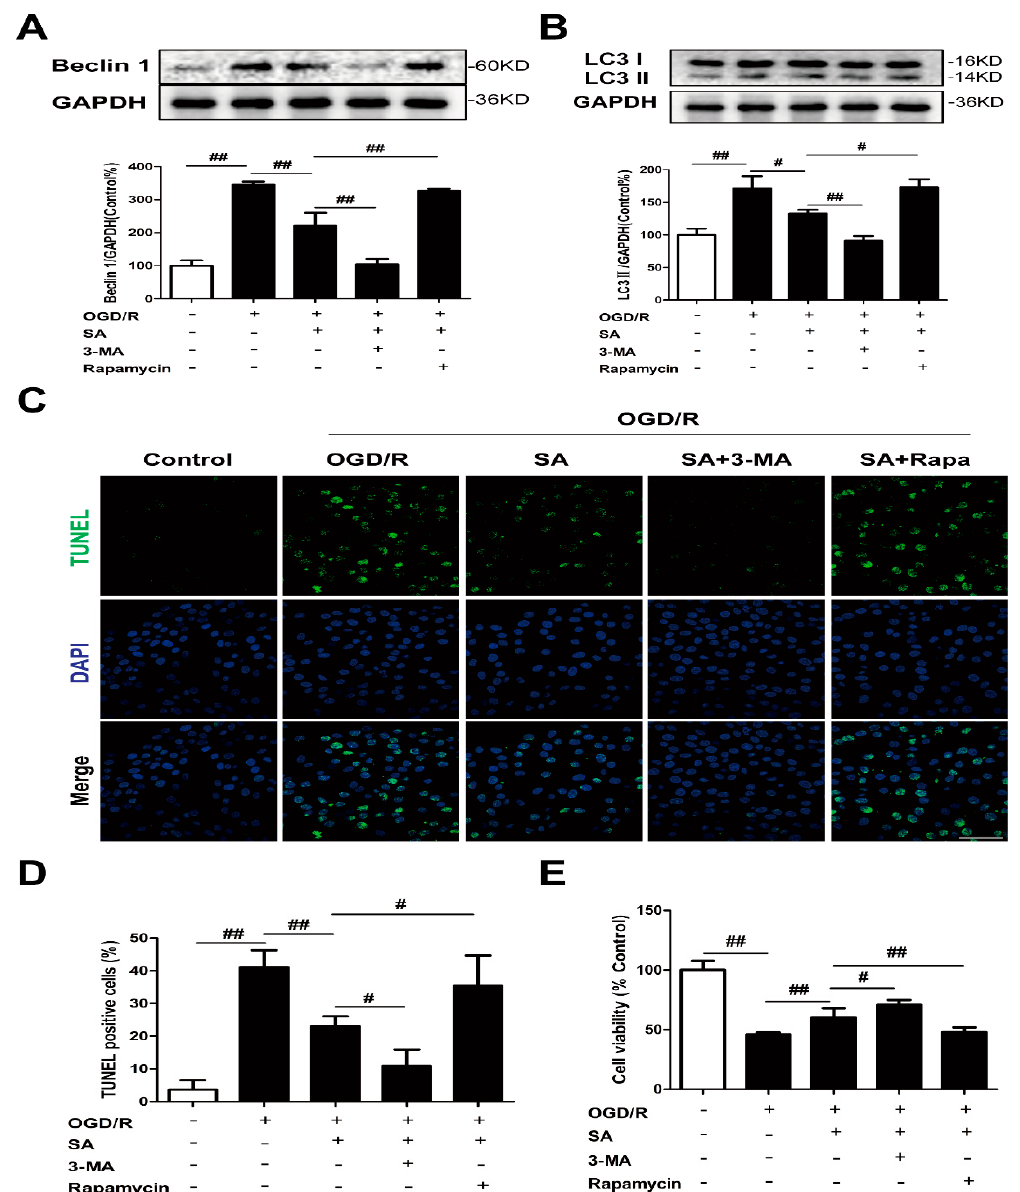
Figure 4. Autophagy contributes to the neuroprotective effects of SA in PC12 cells. PC12 cells were treated with SA (10 μ M) and 0.1 μ M rapamycin or 3 mM 3-MA and then exposed to OGD/R. The expression of Beclin 1 ( A ) and LC3 ( B ) was detected by Western blot (n = 3). ( C , D ) Apoptotic cell death was detected by TUNEL staining (n = 6). Scale bar: 20 μ m. ( E ) Cell viability was determined using the MTT assay (n = 6). All data are mean ± SD. # P < 0.05 and ## P < 0.01.